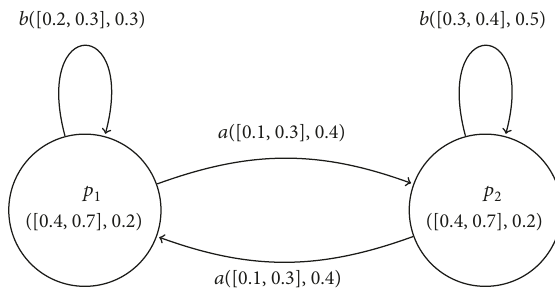
Figure 4: Good subsystem ̂𝜑 𝑔 of cubic fssm T . Figure 5: Strong subsystem ̂𝜑 𝑠 of cubic fssm T